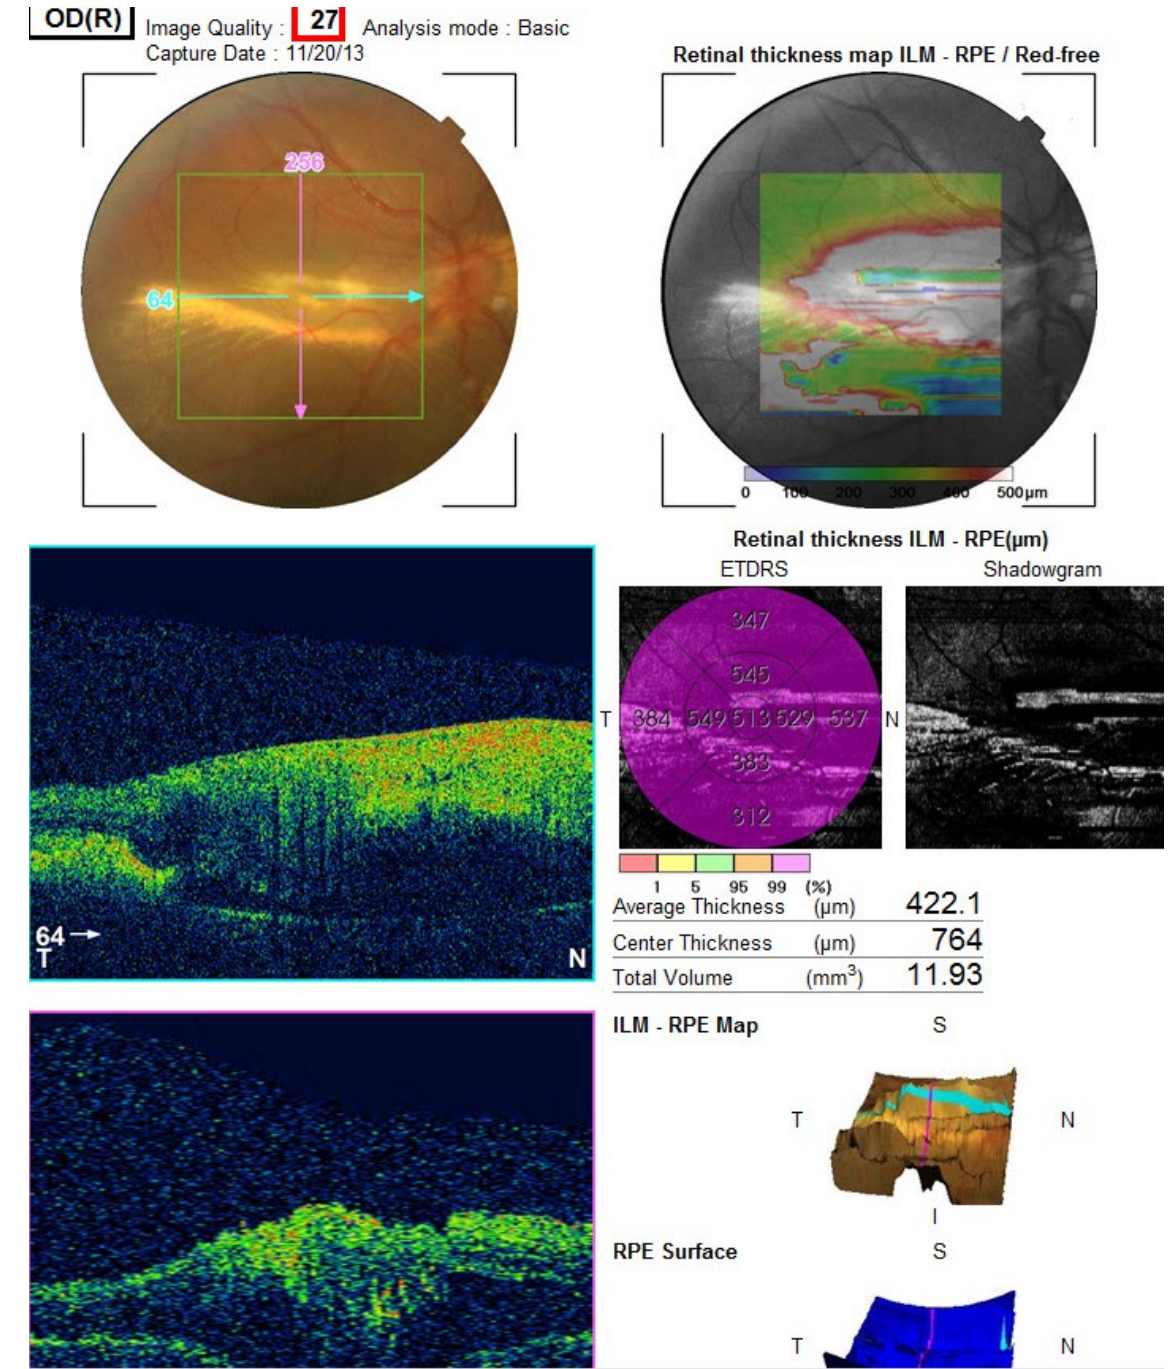
Figure 5: Macular OCT of the right eye with central thickness of 764 µm and subretinal